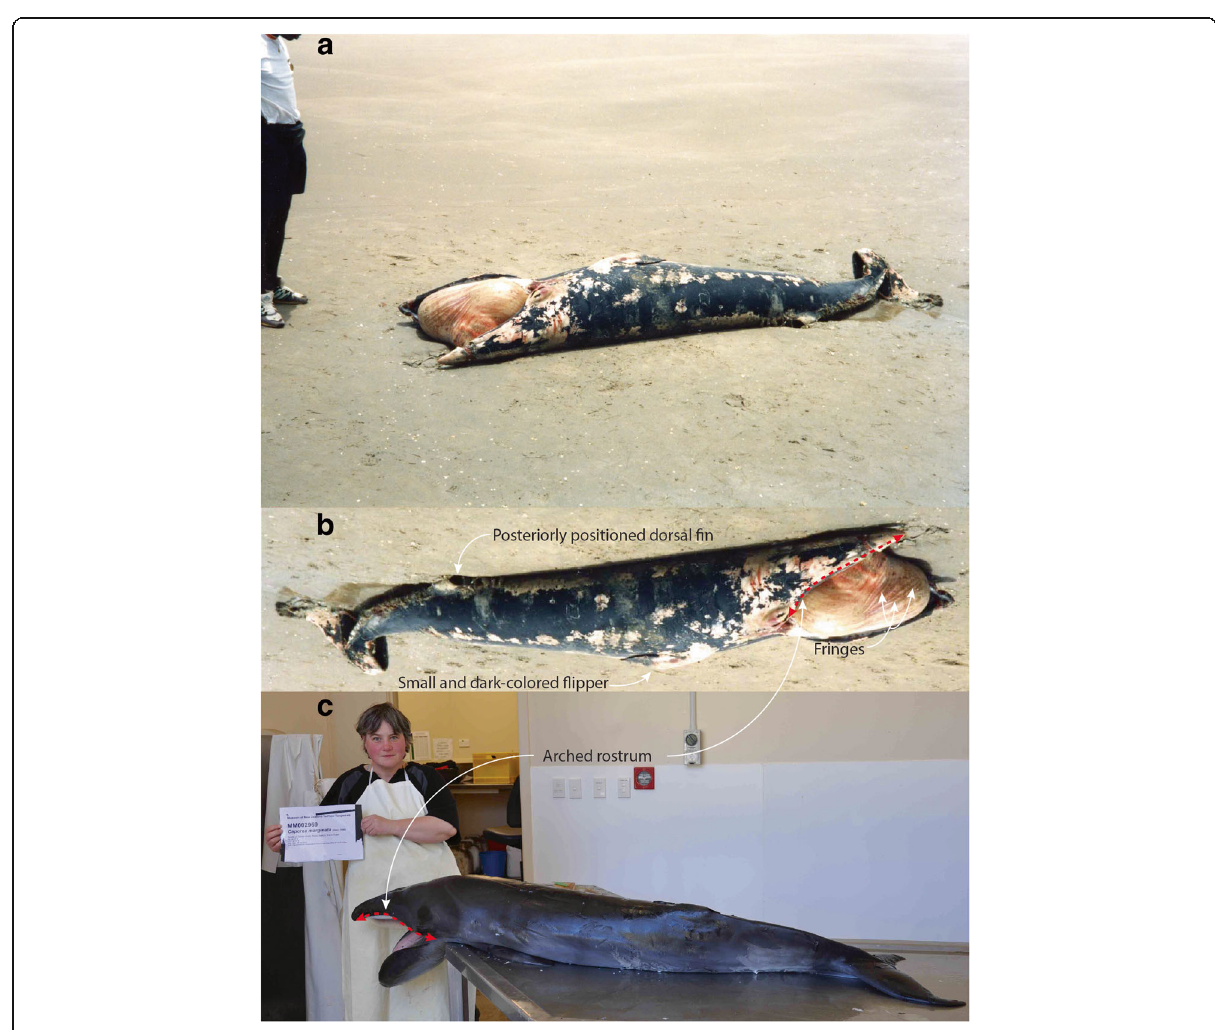
Fig. 1 A pygmy right whale Caperea marginata from The Gambia, Africa. a The original photo of the Gambia Caperea by Bengt Larsen in the files of Marine Mammal Program, Department of Vertebrate Zoology, Smithsonian Institution; ( b ) The same image, edited to facilitate taxonomic comparisons (mirror image of ( a )). c A stillborn C. marginata NMNZ MM002959 from New Zealand for comparison (photo by CHT). A key diagnostic feature, arched rostrum, is illustrated. NMNZ, National Museum of New Zealand (Te Papa Tongarewa), Wellington, New